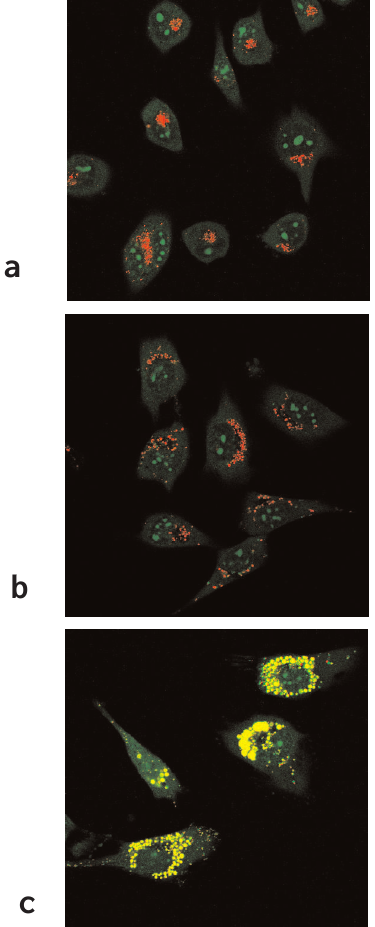
Figure 1: Acridine orange staining as marker for lysosomal pH. In control cells (a) and in cells exposed to 20 m g/ml 20 nm polystyrene particles (b) lysosomes can be discerned as fine, red fluo- rescent dots, whereas the swollen lysosomes induced by exposure to the lysosomotropic agent chloroquine (c) are seen as coarse yellow